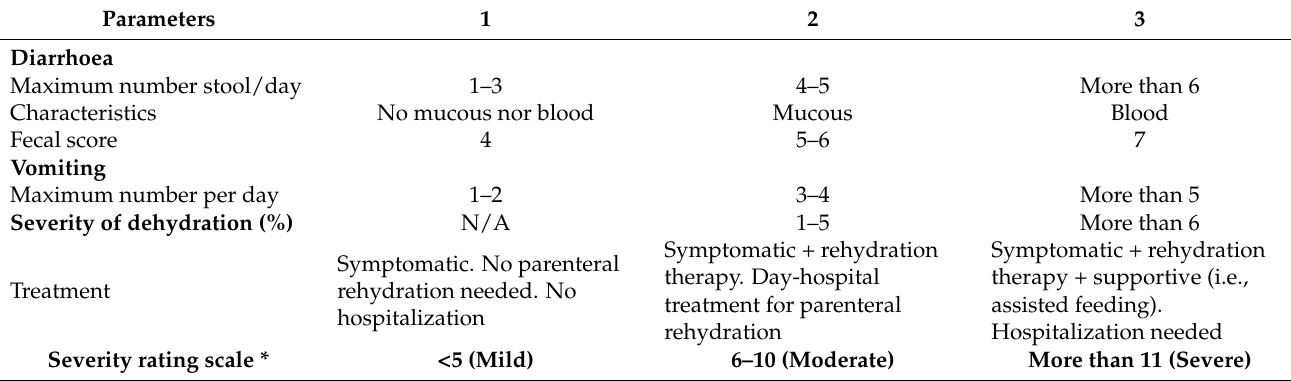
Table 1. Modified-Vesikari Scoring System